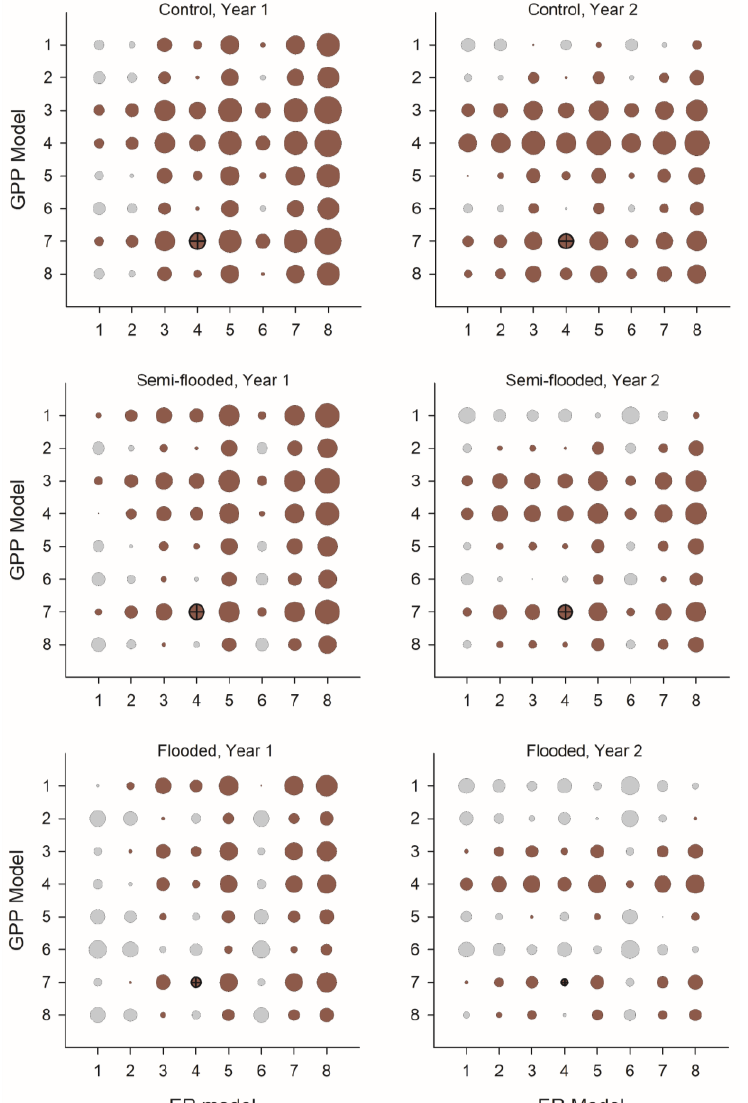
Figure 9. Bubble plot of resulting emission factors of CO derived from net ecosystem exchange (NEE) of 2 CO and biomass yield C export for individual treatments and study years. NEE of CO was derived by 2 2 combining the eight times eight ecosystem respiration (ER) and gross primary production (GPP) models (as depicted in Tables 1 and 2). Maximum symbol size corresponds to numerical emission factors of 709 g CO - 2 C m -2 year -1 . Grey symbols indicate negative emissions (sink of CO ); maroon symbols show positive 2 emissions (source of CO ). Maroon symbols with cross show the resulting CO emission factor from the 2 2 two selected models, ER Model 4 and GPP Model